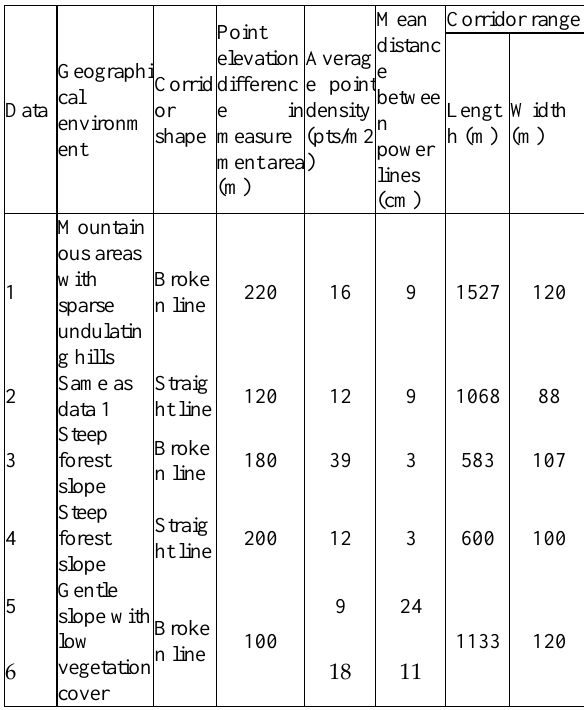
distance ∆h between each power line, as shown in Figure 3.